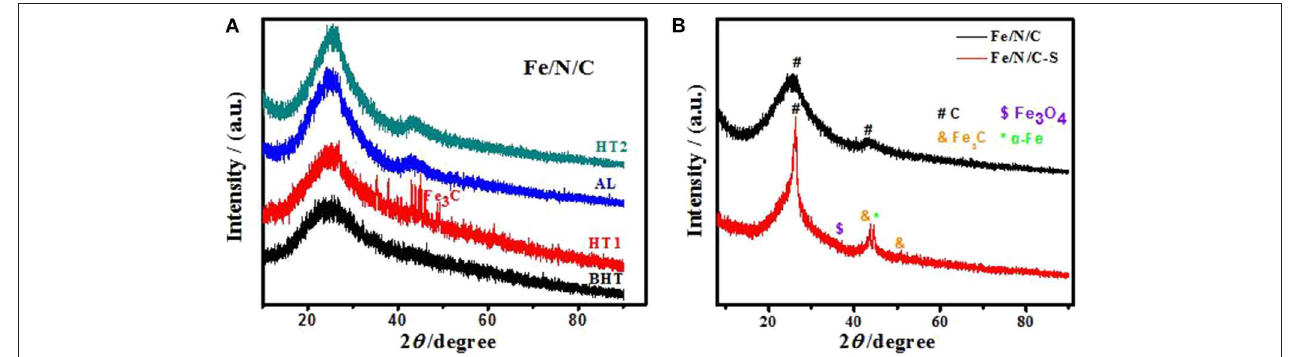
FIGURE 2 | XRD patterns of (A) the Fe/N/C electrocatalyst at different preparation stages, (B) the Fe/N/C and Fe/N/C-S electrocatalysts after HT2.